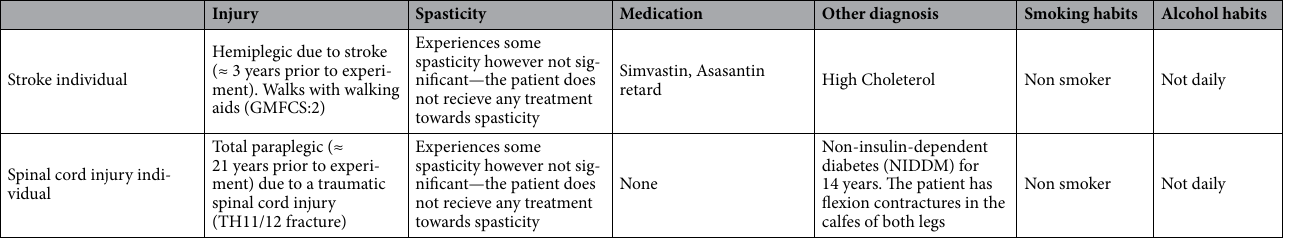
Table 2. Clinical history. GMFCS gross motor function classification